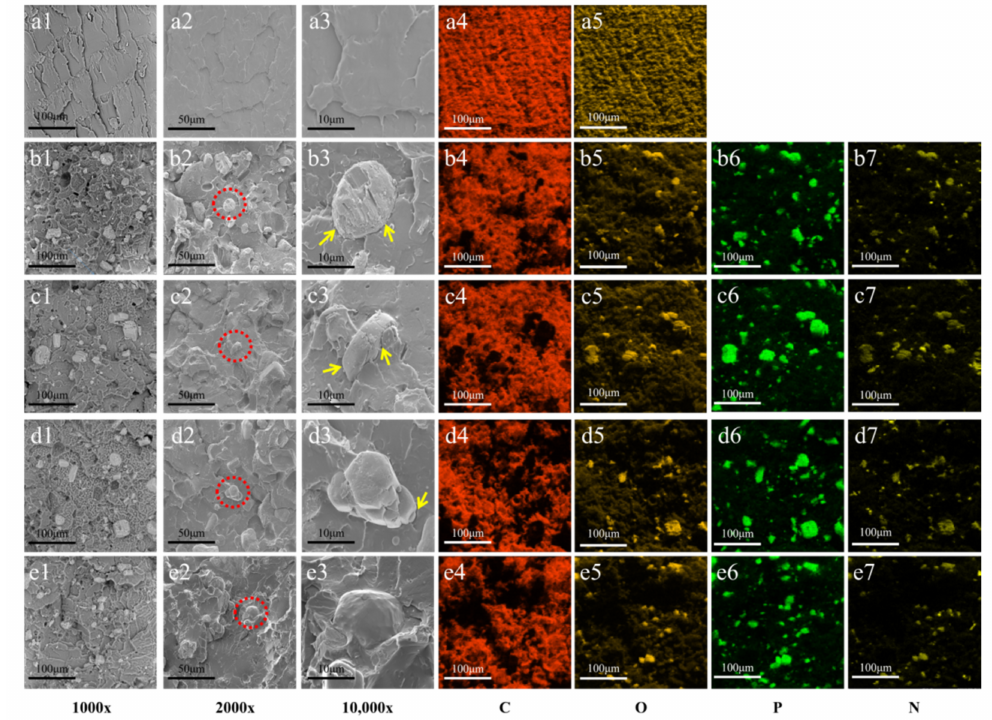
Figure 3. SEM photos of the impact fracture surface: ( a ) PLA; ( b ) FRPLA; ( c ) 0.9DCP/FRPLA; ( d ) 0.3TAIC/FRPLA; ( e )